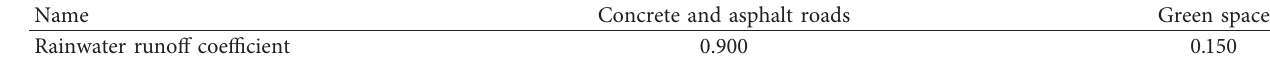
Table 5: Rainwater runoff coefficient